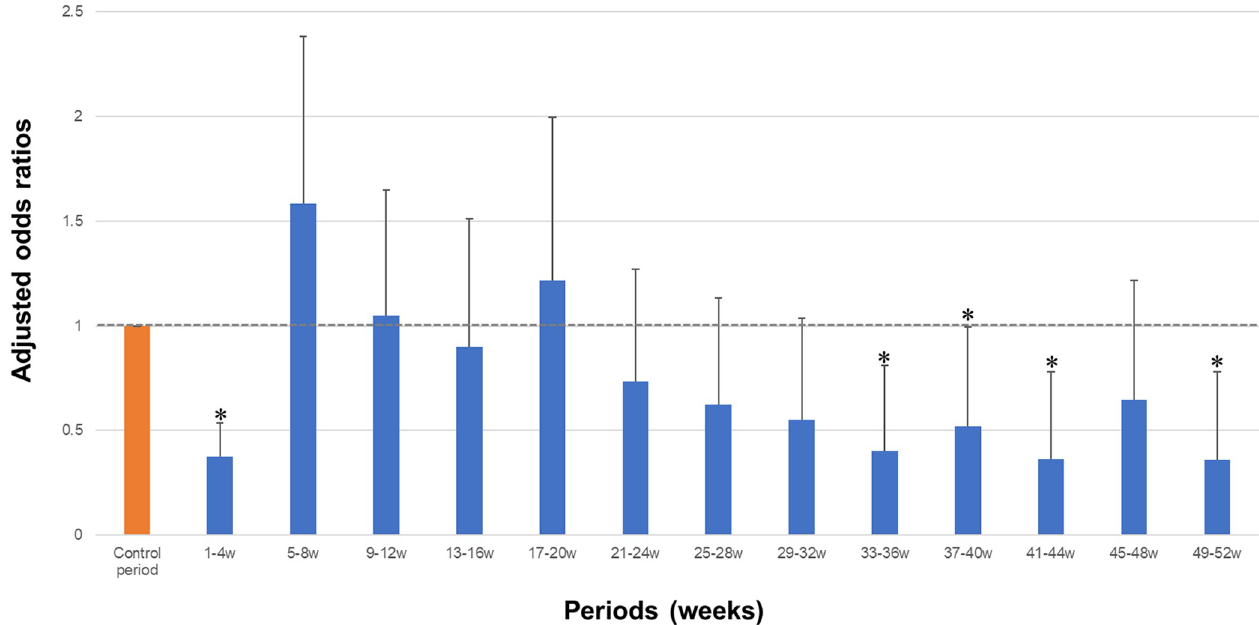
Fig 4. Odds ratios for each case period compared with the control period. Estimates and their 95% confidence intervals were derived from the self- controlled case series using conditional logistic regression. The model was adjusted for each season. � P < 0.05.